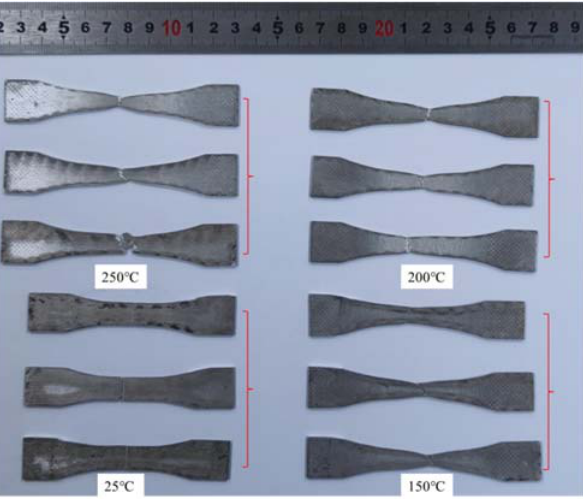
Figure 3. Specimens after tensile testing.